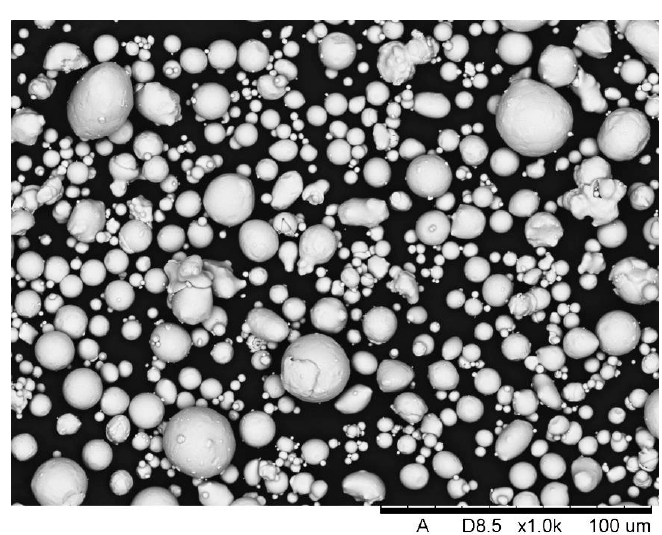
Figure 3. Spherical morphology of Cu powder that was used in APS process.